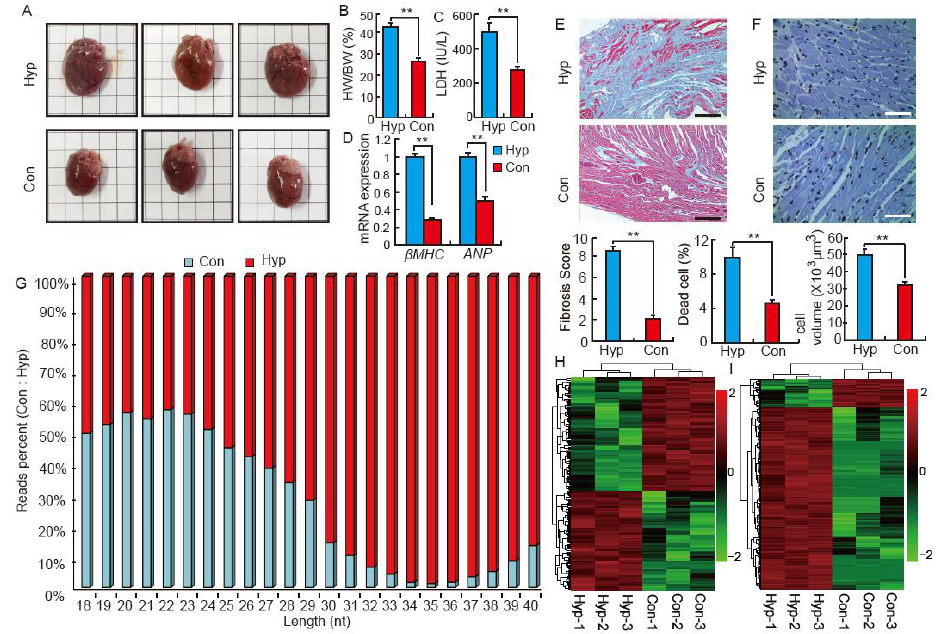
Figure 1. Isoproterenol (ISO) induces cardiac hypertrophy and influences small RNA distribution in SD rats. ( A ) Images of whole hearts from control (Con) and isoproterenol-induced (Hyp) Sprague Dawley (SD) rats, n = 8; ( B ) The ratio of the heart weight to body weight (HW/BW) in Con and Hyp groups, n = 8. Data are means ± SD. ** p < 0.01; ( C ) The activity of serum lactate dehydrogenase (LDH) in Con and Hyp groups, n = 8; ( D ) Relative expression of mRNA of β -MHC and ANP . The qRT-PCR analysis was performed in triplicate with three independent samples; ( E ) Cardiac fibrosis evaluated by Masson trichrome staining. Scale bar = 200 µ m, n = 8; ( F ) Histological analysis of heart tissue in Hyp and Con groups by Terminal deoxynucleotidyl transferase dUTP nick end labeling (TUNEL) staining.